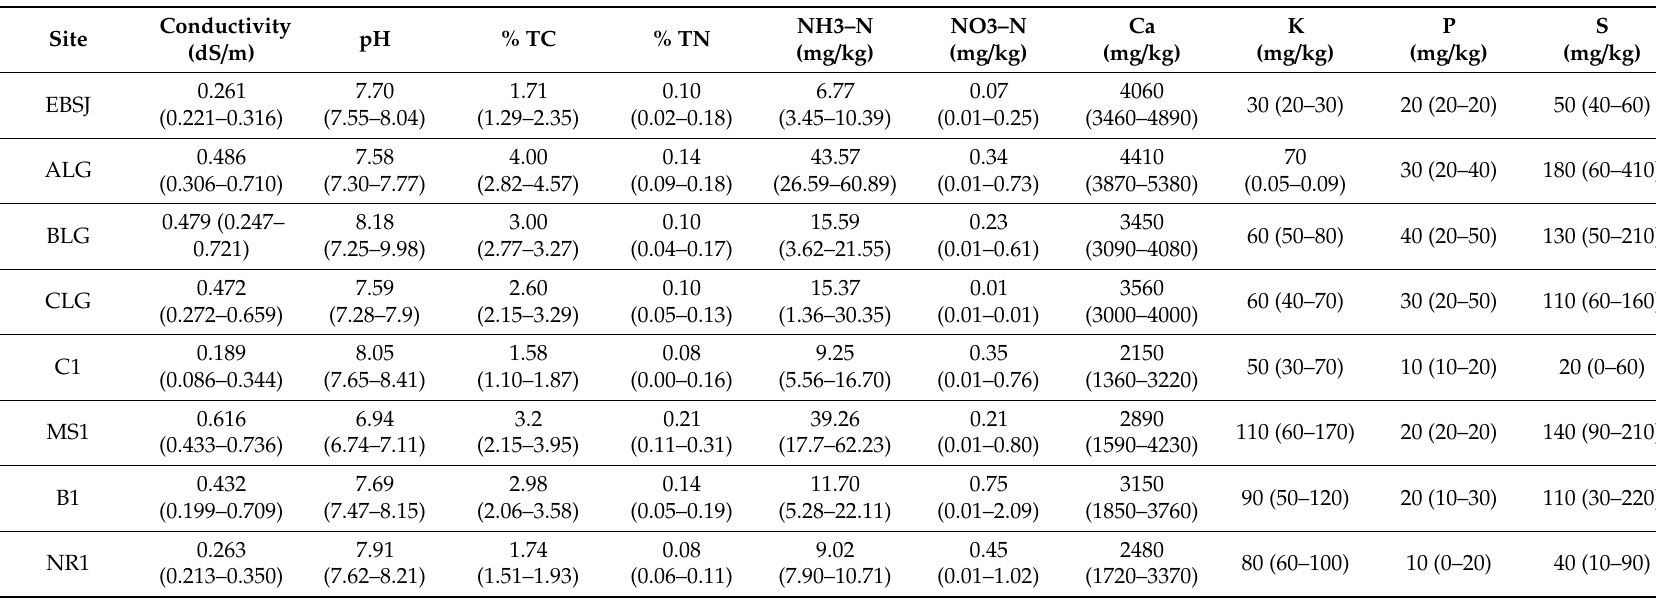
Table 3. Mean values and minimum–maximum alues (in parentheses) of two physicochemical and eight nutrient characteristics of sediment from eight